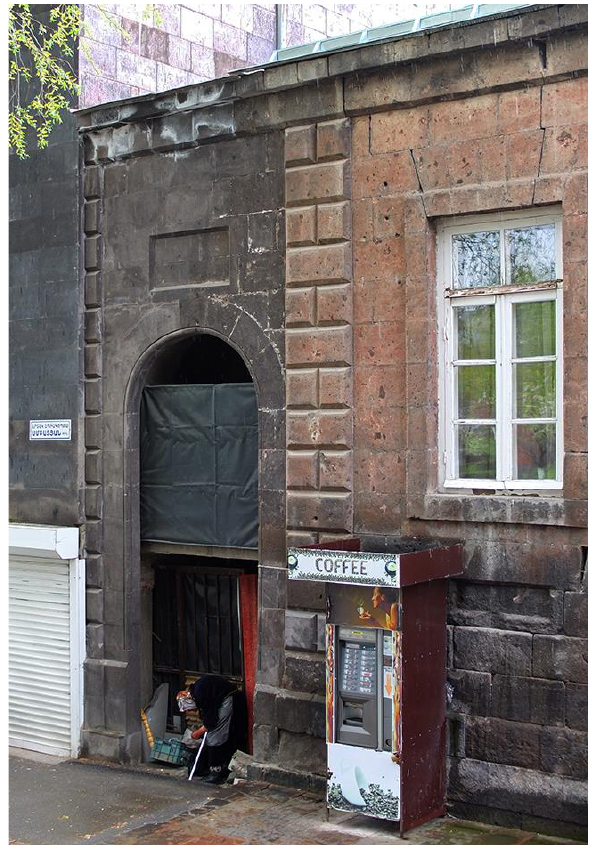
Figure 23. Archway connecting the modernist and the historical black tuff buildings. Photo by the author,